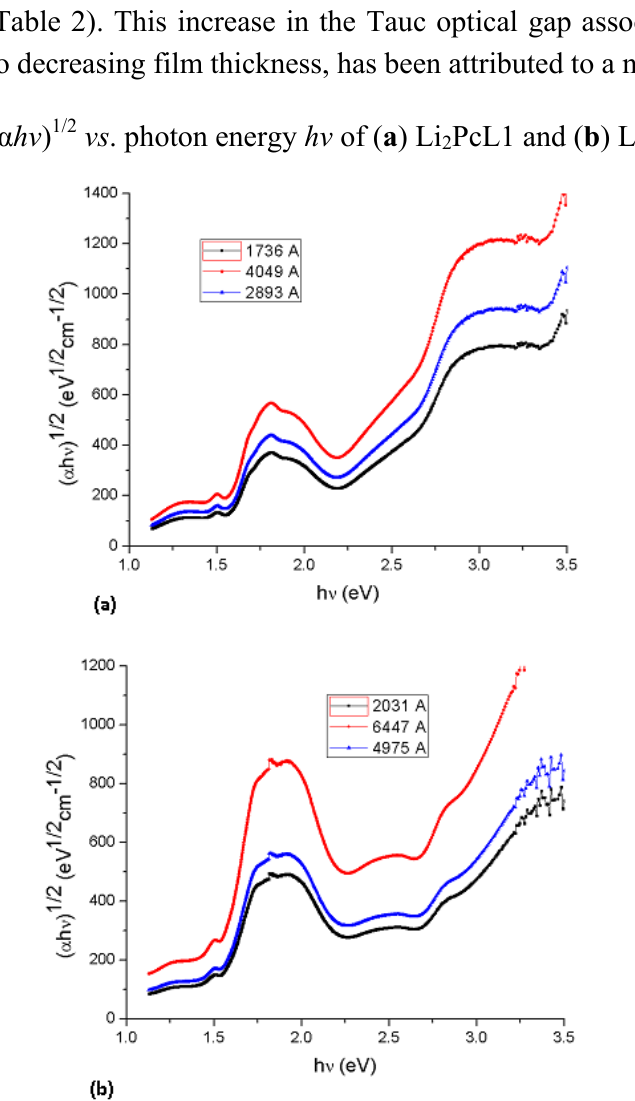
Figure 6. Plot of ( α h ν ) 1/2 vs . photon energy h ν of ( a ) Li